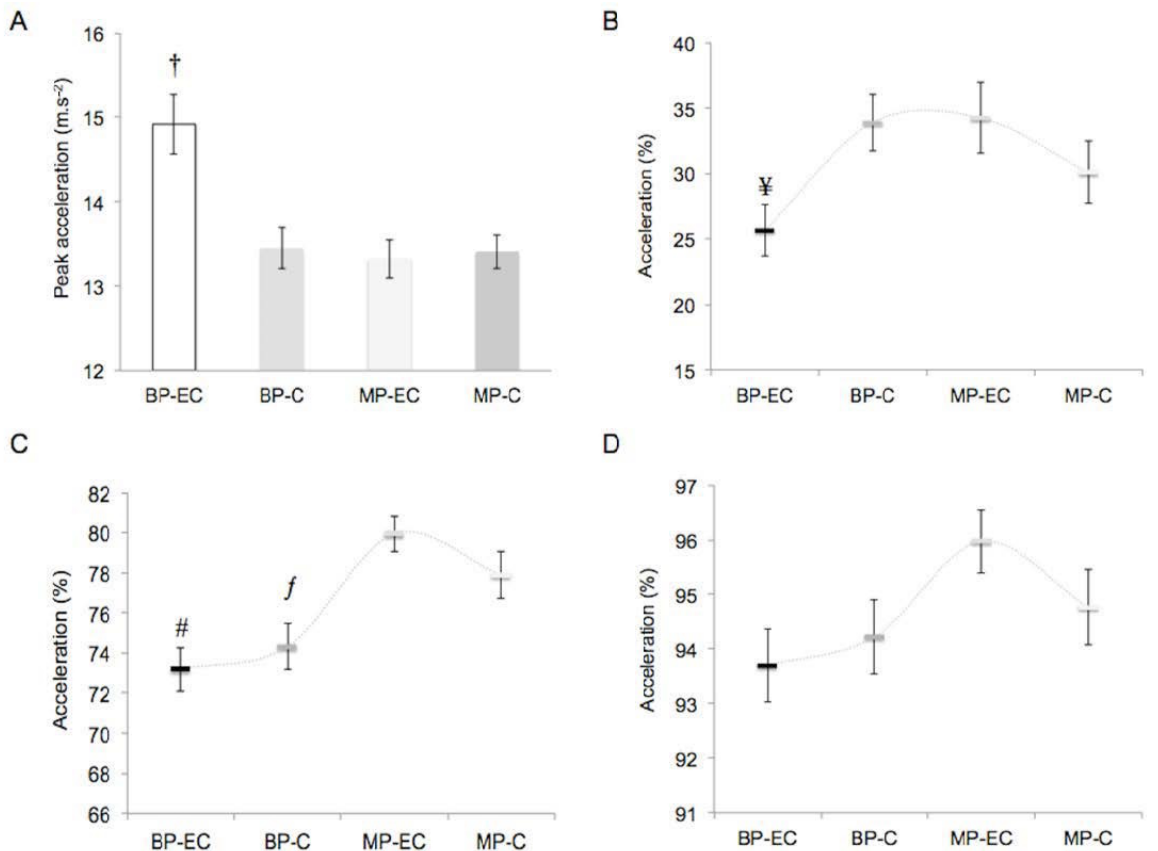
Figure 3. Acceleration data in the military press (MP) and bench press (BP) tests. ( A ) Peak acceleration. ( B ) Portion of the concentric phase (%) at which peak acceleration was detected. ( C ) Portion of the concentric phase (%) where acceleration up to the peak velocity was detected. ( D ) Portion of the concentric phase (%) where acceleration up to the braking phase was detected. Abbreviations: C = concentric; EC = eccentric–concentric. † Significantly different to BP-C ( p = 0.001), MP-EC ( p = 0.001), MP-C ( p = 0.002). ¥ Significantly different to BP-C and MP-EC ( p < 0.05). # Significantly different to MP-EC ( p < 0.001) and MP-C ( p = 0.021). ƒ Significantly different to MP-EC ( p = 0.003).